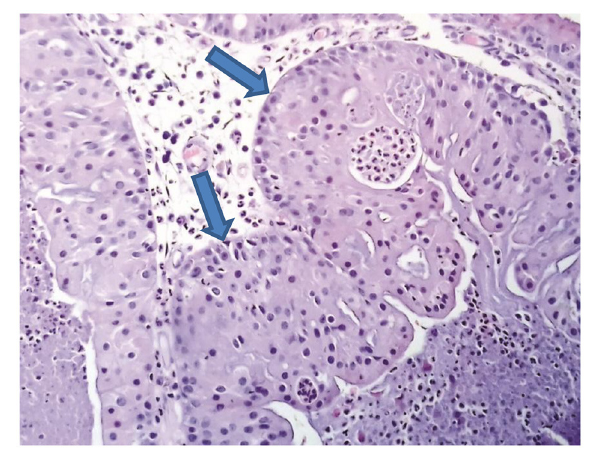
FIGURE 4 | H & E staining. Structures of oncocytic Schneiderian